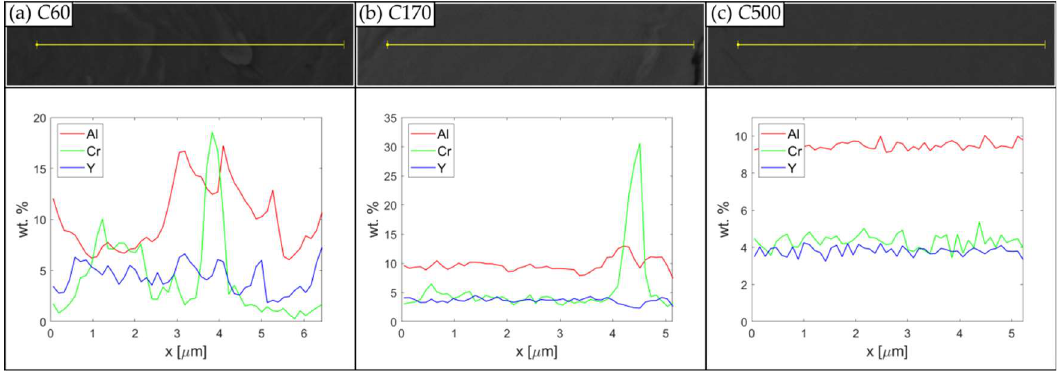
Figure 4. EDS line scans of powder particles of ( a ) C 60, ( b ) C 170, and ( c ) C 500 . The attempts to reveal the grain microstructure in the powder particles by using BSE or EBSD mapping at the metallographic cuts are not successful due to the very small grain size and very high dislocation density. That is why the powder C 60 is analyzed by TEM, showing the UFG microstructure of the FeAlOY powder of about 50 nm (Figure